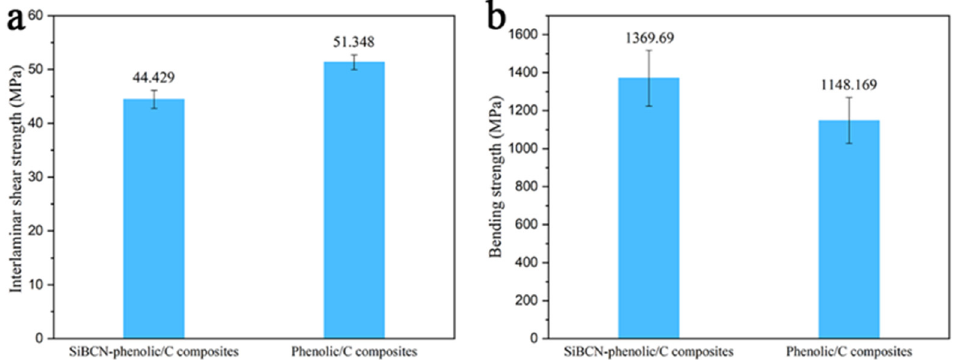
Figure 13. Interlaminar shear strength ( a ) and bending strength ( b ) of the phenolic/C composites and the SiBCN–phenolic/C composites.